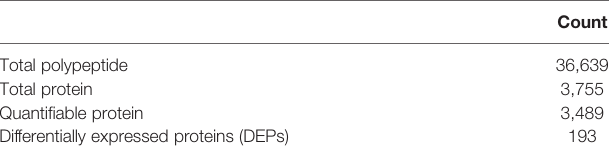
TABLE 2 | Statistical results of polypeptides and